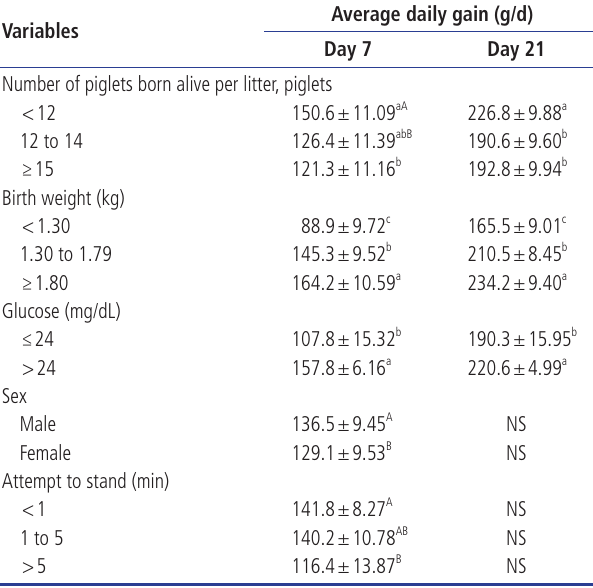
Table 7. Predictive factors included in the final models for average daily gain (least square means±standard error of the mean) from birth until 7 and 21 days of life from multivariate analyses